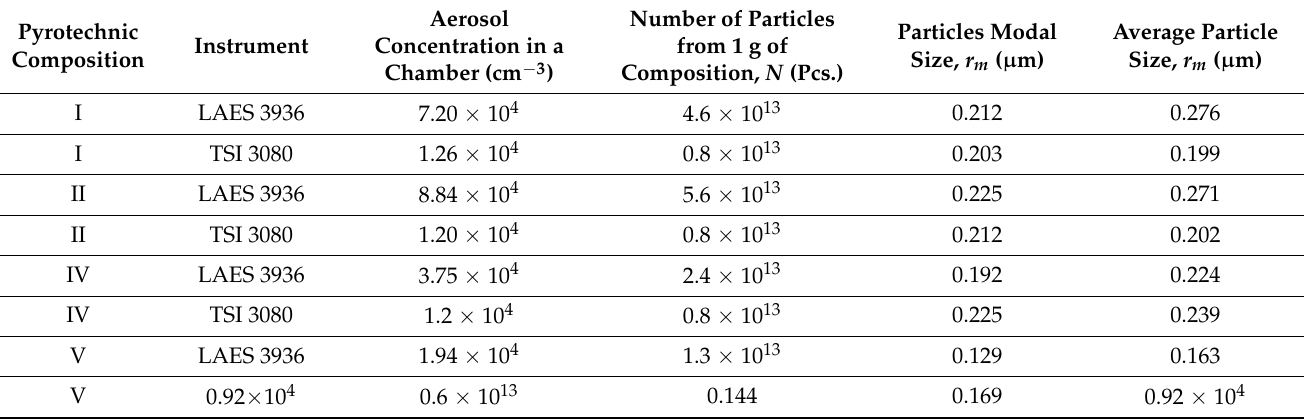
Table 1. Main characteristics of the aerosol generated by pyrotechnic checkers filled with different compositions I, II, IV and V.